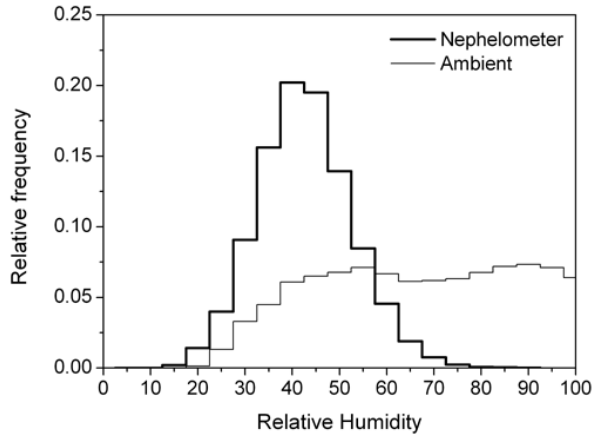
Fig. 1. Relative frequency distributions of measured ambi- ent RH at the site and measured RH inside the nephelometer’s sensing